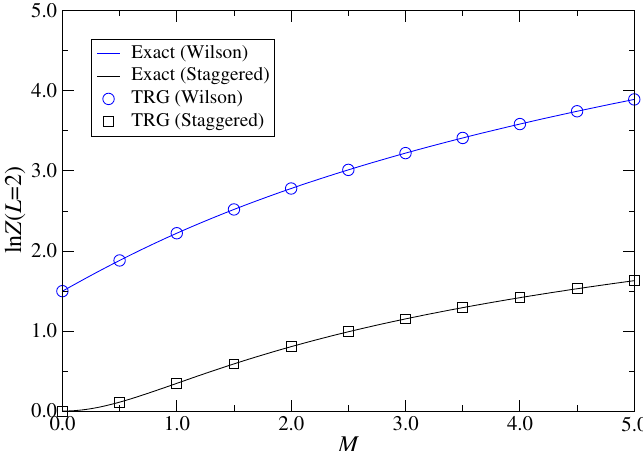
Figure 5 . Free energy densities for free Wilson and staggered fermions against the mass M on 2 × 2 lattice with D = 16 . They agree with the exact values up to the machine precision.